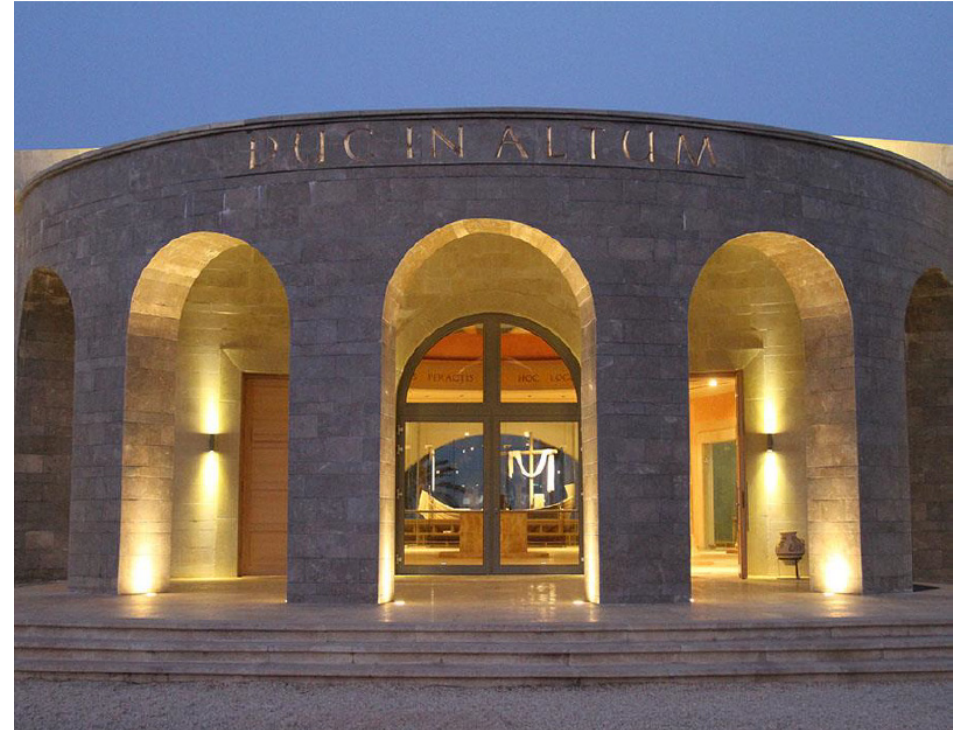
Figure 1. West Façade, Duc in Altum Worship Center, 2014 (photo: PD).